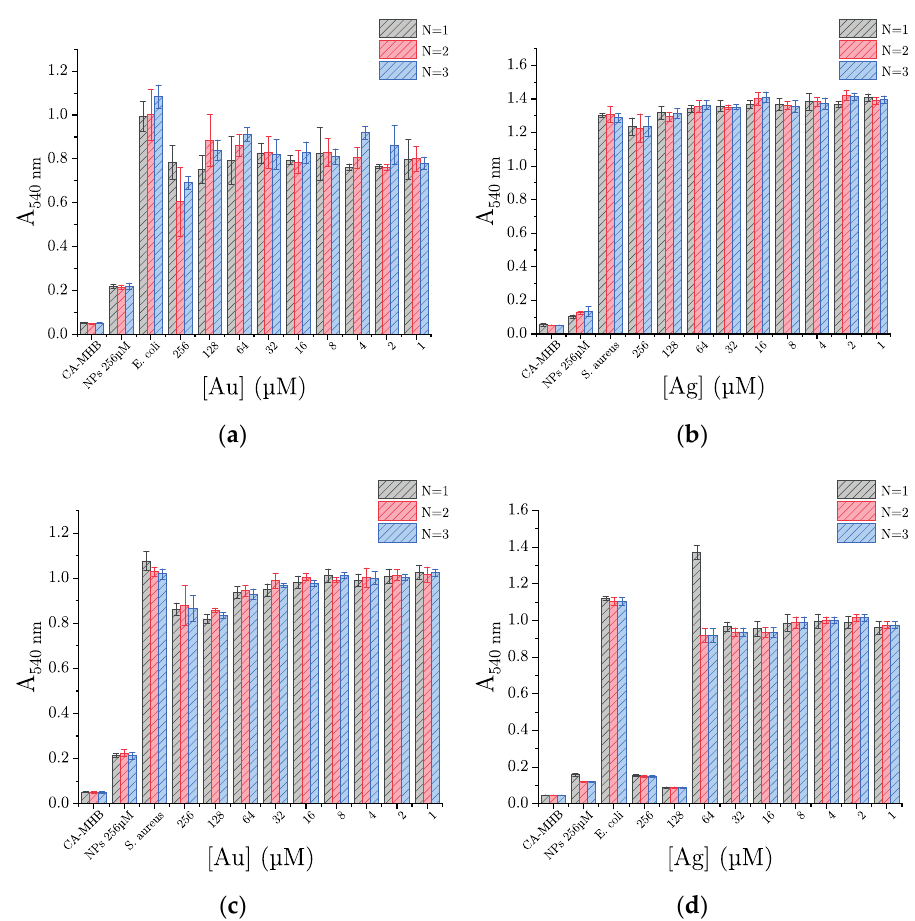
Figure 7. AgNPs and AuNPs antibacterial activity evaluation against ( a , b ) Staphylococcus aureus ATCC 29213 and ( c , d ) Escherichia coli ATCC 25922. “CA-MHB”: Culture medium control (i.e., culture medium free of bacteria and nanoparticles); “NPs 256 µM”: Nanoparticles control (i.e., bacteria-free culture medium, but with nanoparticles at 256 µ mol/L); “ S. aureus or E. coli ”: Bacterial growth control (i.e., growing bacteria free of nanoparticles).